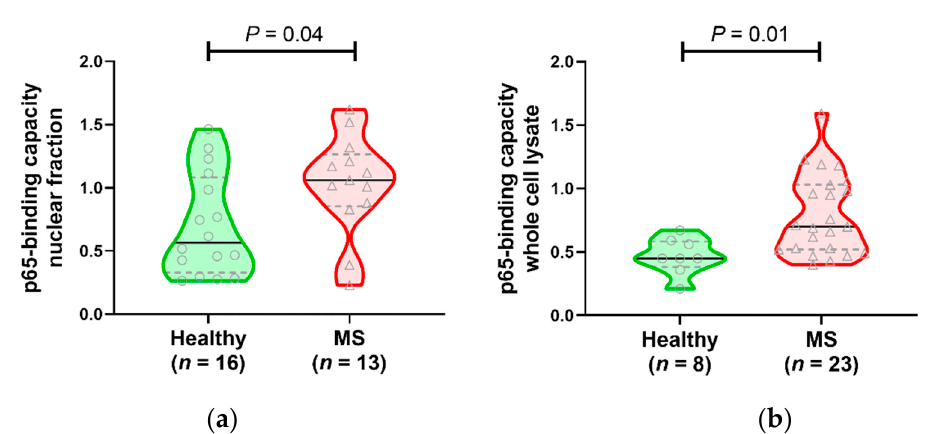
Figure 3. DNA binding activity of p65 from MS patients and healthy subjects. ( a ) p65 binding to the consensus DNA oligonucleotide in cell nuclear extracts was significantly elevated in MS patients compared to healthy individuals. ( b ) In whole cell lysates, the amount of p65 that could bind to the consensus DNA oligonucleotide was also significantly elevated in MS. In these violin plots, a solid line indicates the median, and dotted lines show the interquartile range. Analyzed by two-tailed Mann–Whitney U test.